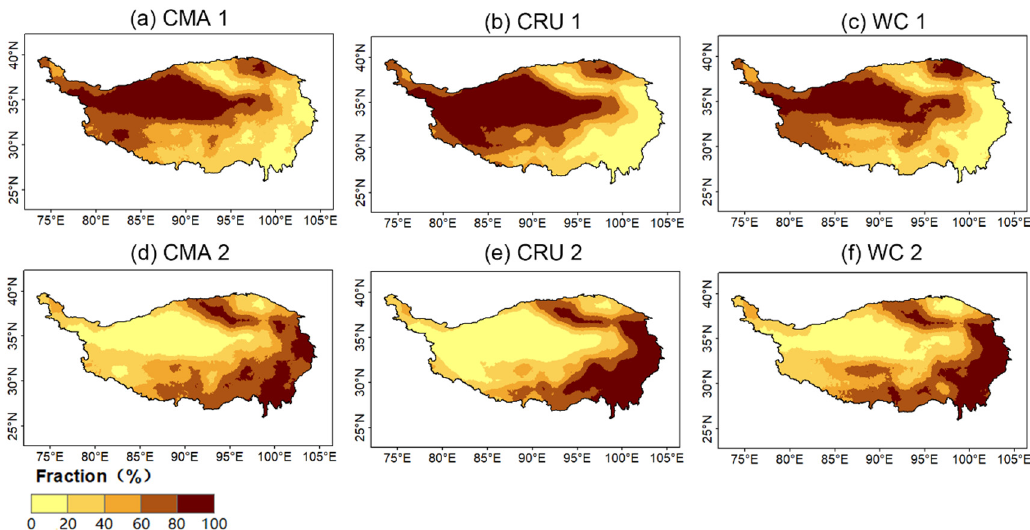
Figure 5. Maps showing the membership fraction of each cluster using the three climatological databases (CMA, CRU, and WC). Subfigures ( a ), ( b ), and ( c ) show cluster 1, and ( d ), ( e ), and ( f ) are cluster